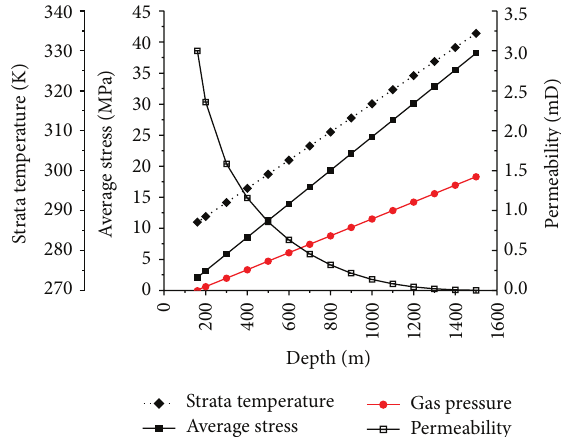
Figure 8: Relationships among strata temperature, average stress, gas pressure, permeability, and the depth of No. 3 coal seam in the